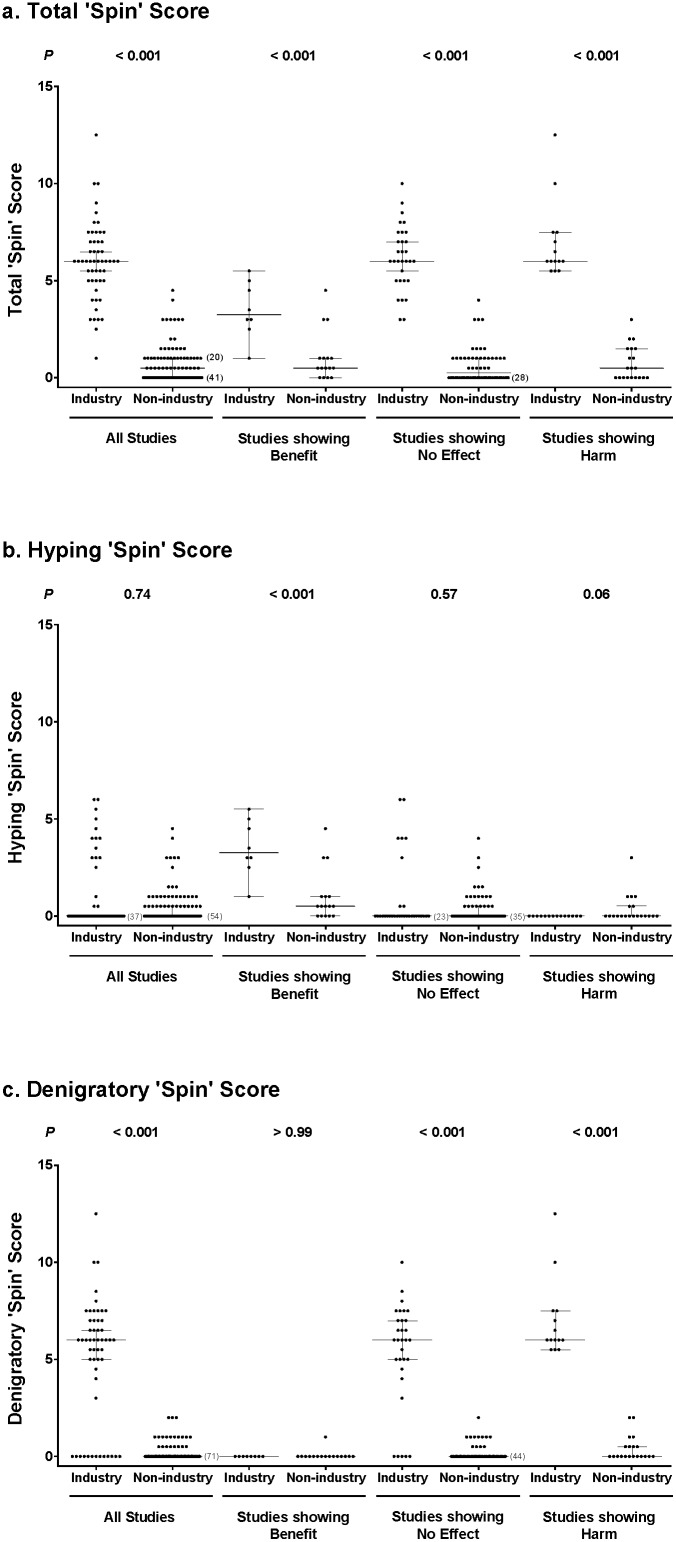
Total (a), hyping (b) and denigratory (c) ‘spin’ scores of industry and non-industry media responses, according to outcomes of source publications.Each point represents the ‘spin’ score of an individual media response. Where multiple scores of the same value occur, the number of overlapping ‘spin’ scores is indicated in parentheses to the right of the overlapping values. Bars represent the median and 95% CI.